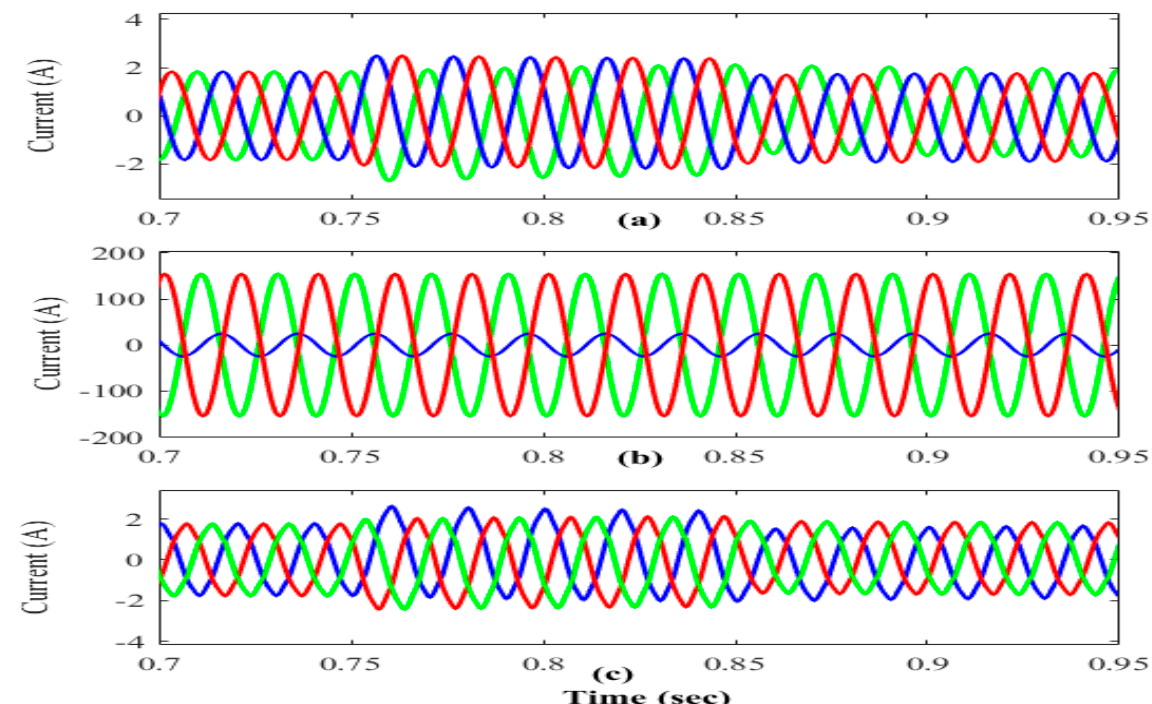
Figure 18. Analysis of current swell conditions ( a ) Source Current ( b ) Load Current ( c ) Injected Current.